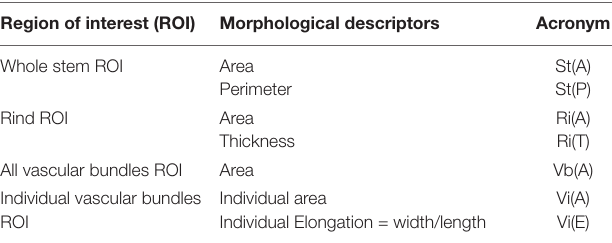
TABLE 1 | Measurement of the raw morphological descriptors: regions of interests (ROIs) used for measurement, morphological descriptors and acronyms. Region of interest (ROI) Morphological